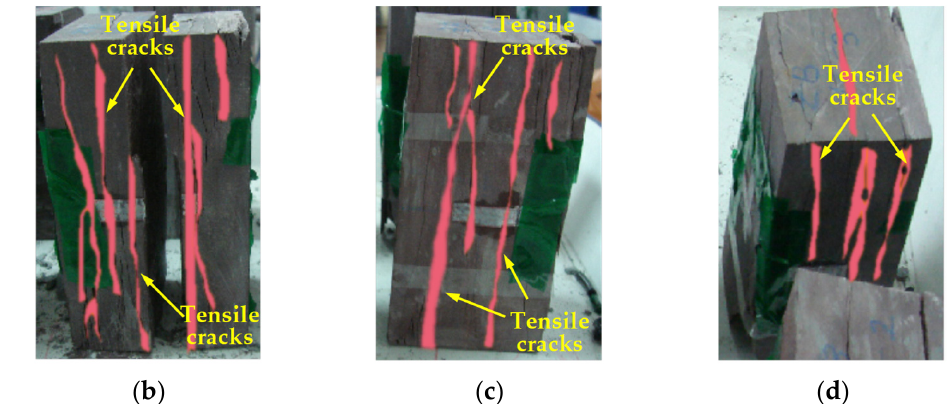
Figure 11. Fracture distribution of gray samples under parallel loading: ( a ) No. 1 sample; ( b ) No. 2 sample; ( c ) No. 3 sample; ( d ) No. 4 sample.